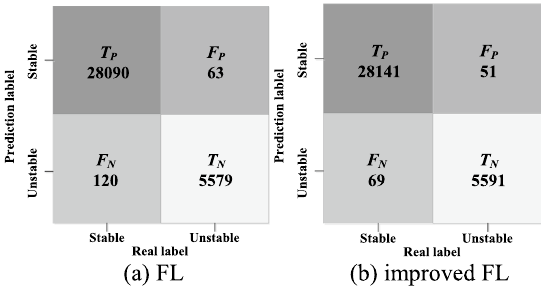
Fig. 10 TSA results on the test data set of the IEEE 145-bus